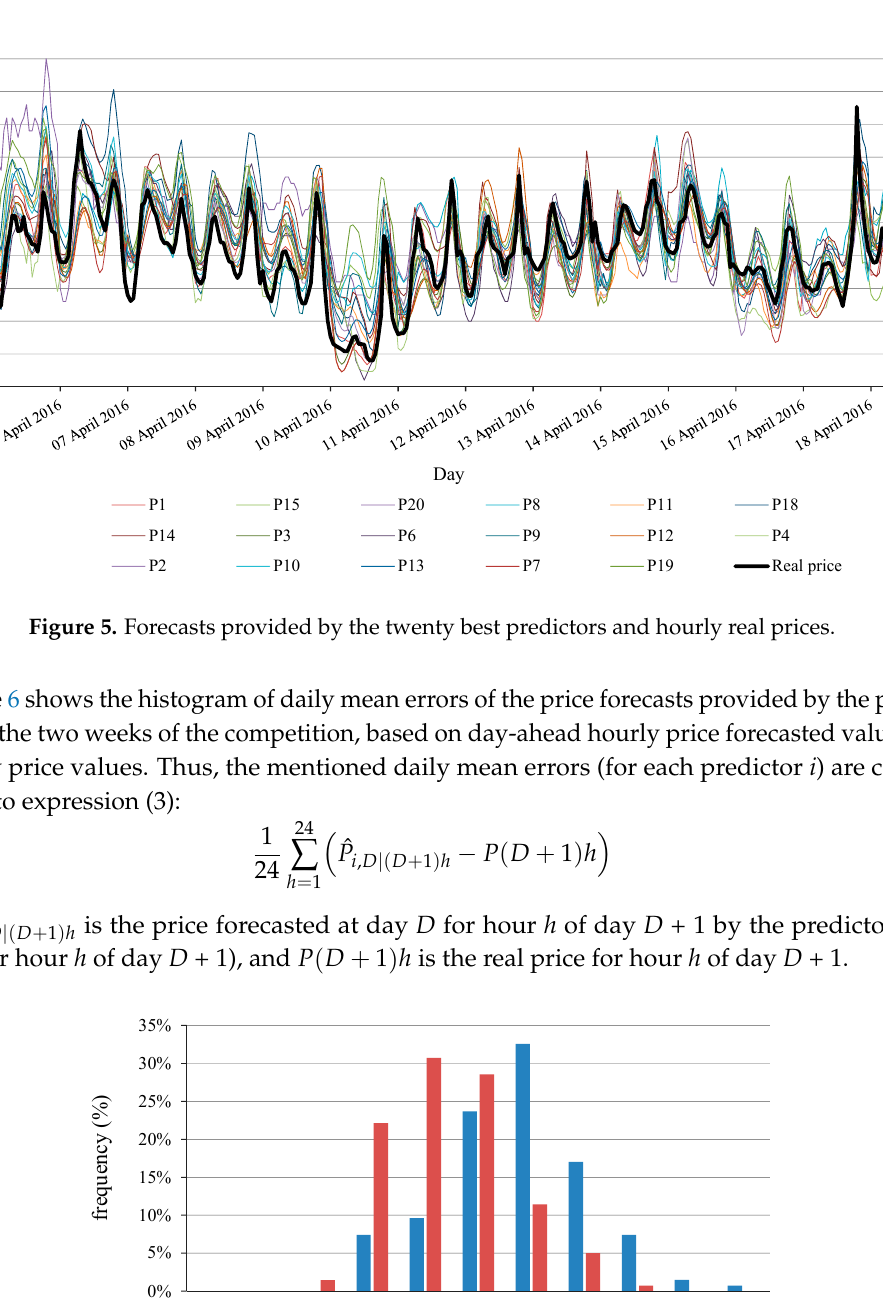
Figure 6. Histogram of daily mean errors for the day-ahead forecast ( D + 1) of prices for the two weeks of the competition.